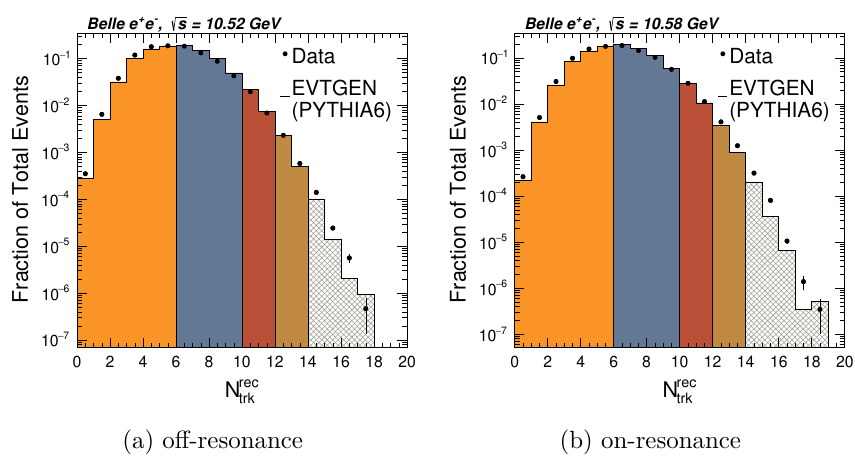
) distributions for (a) off-resonance and (b) trk in [0 , 6) , [6 , 10) , [10 , 12) , trk